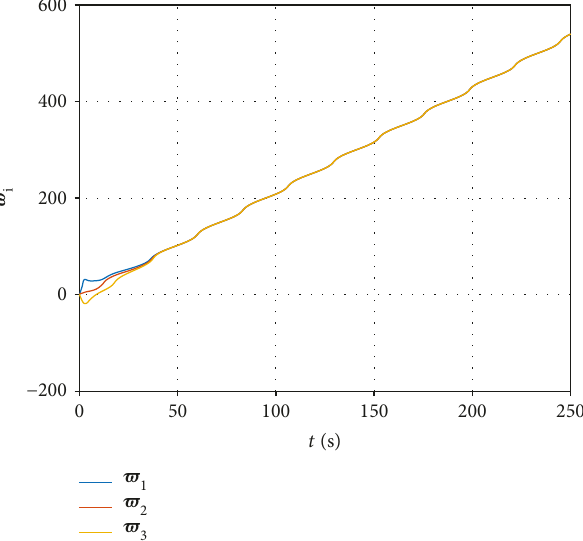
Figure 4: System speeds evolution.